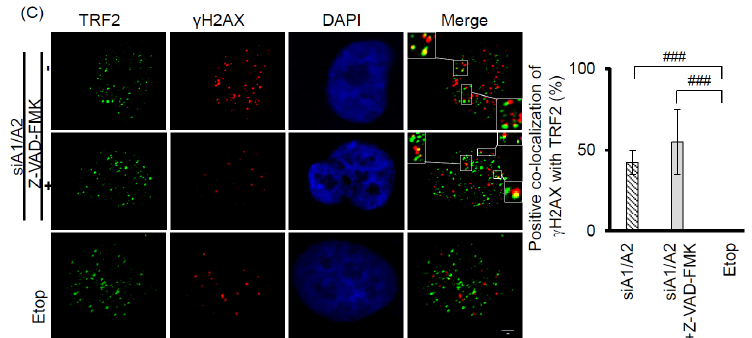
Figure 3. Effects of the apoptosis inhibitor Z-VAD-FMK on the induction of apoptosis, cell proliferation, and DDR. ( A ) A549 cells were transfected with siRNAs targeting hnRNP A1 (siA1), hnRNP A2 (siA2), both hnRNP A1 and A2 (siA1/A2), or with a non-targeting sequence (siNT) for 48 h. Cells transfected with siA1/A2 were cultured in the presence or absence of 20 mM Z-VAD-FMK for